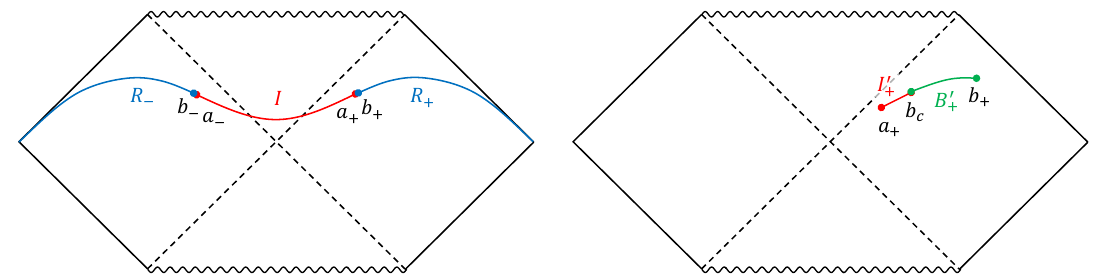
Figure 3 . The island can be maximally extended by putting b ± as close to a ± as possible (left). The entanglement entropy becomes zero when b ± is identical to a ± , while the quantum extremal surface becomes unstable when the radius at b ± becomes b c , implying that the quantum extremal surface rolls down to a global minimum at b ± . A part of B overlaps with the maximally extended island. This part I 0 in B is interpreted as a consequence of the replica trick, and referred to as “hidden island” in this paper. Thus, the region B consists of the essential region of the black hole B 0 and the hidden island I 0 (right). The information of the black hole is localized at the stretched horizon at b c